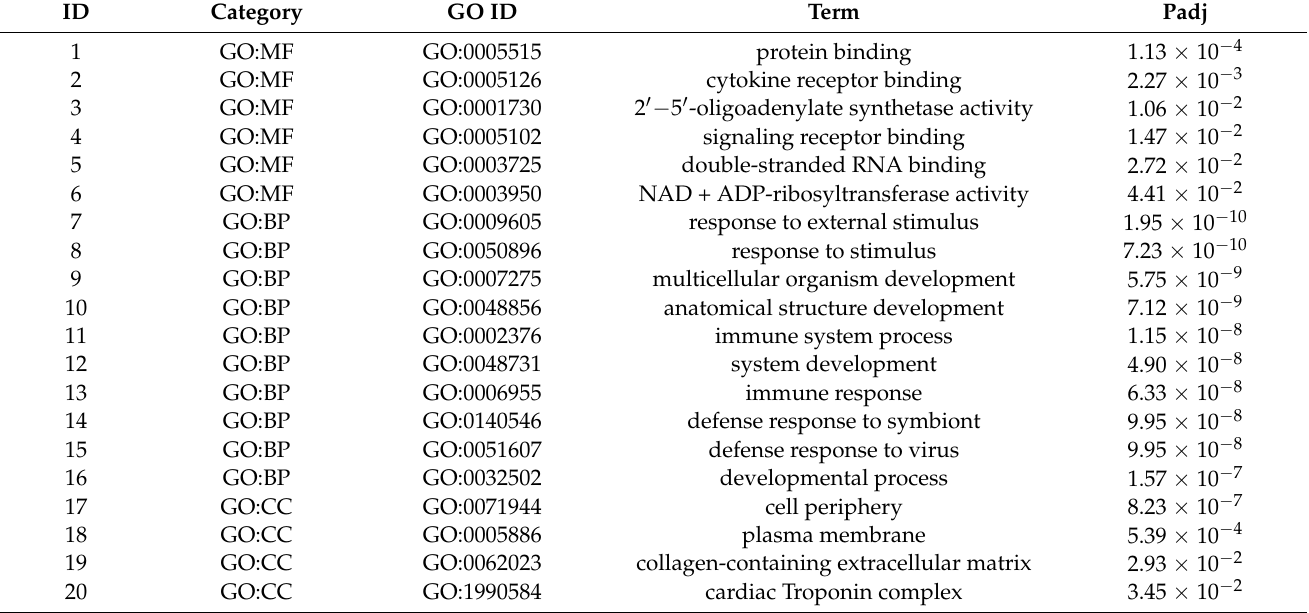
Table 5. Top 10 of each gene ontology (GO) molecular function (MF), biological processes (BP), and cellular component (CC)